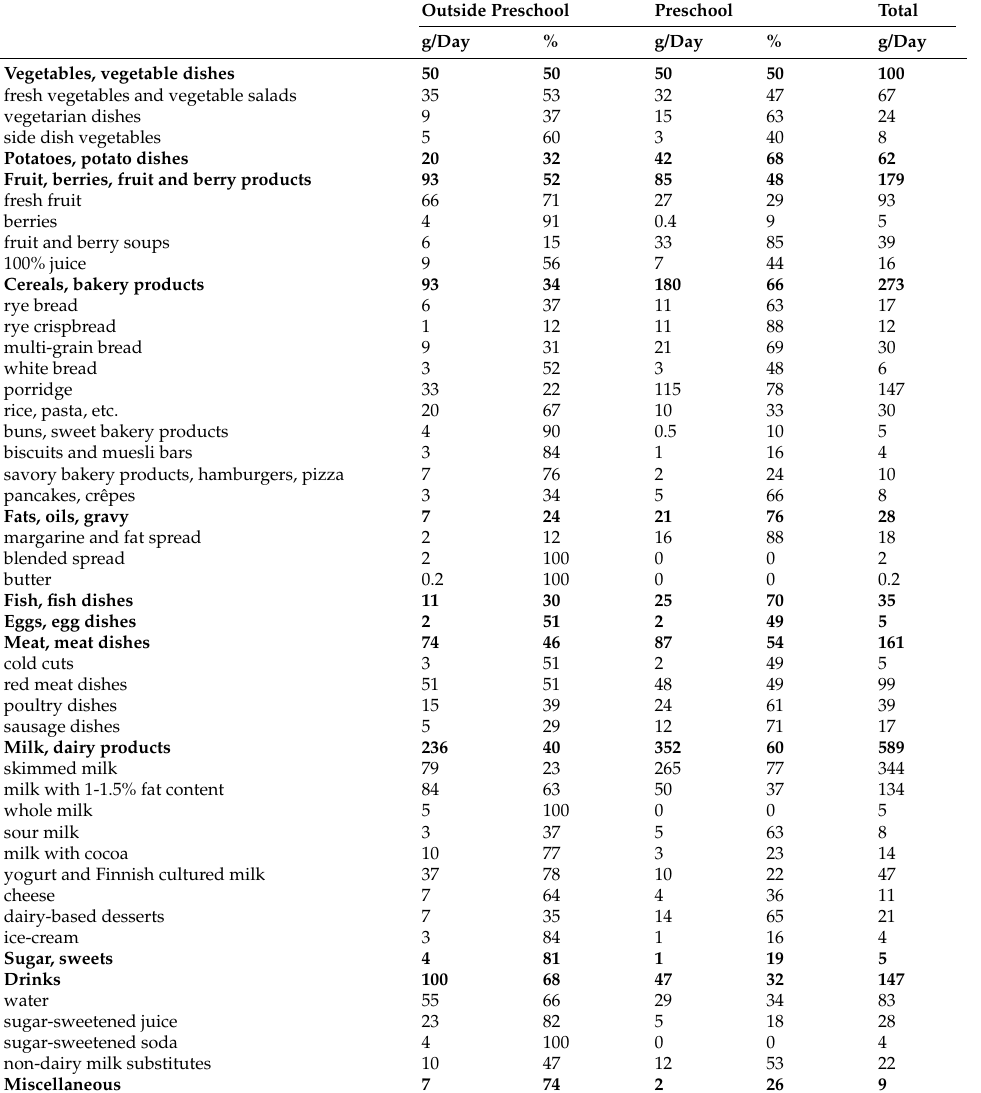
Table 2. Mean food consumption on preschool days (Monday to Friday) of 3- to 4-year-old Finnish children who eat three meals at preschool ( n =